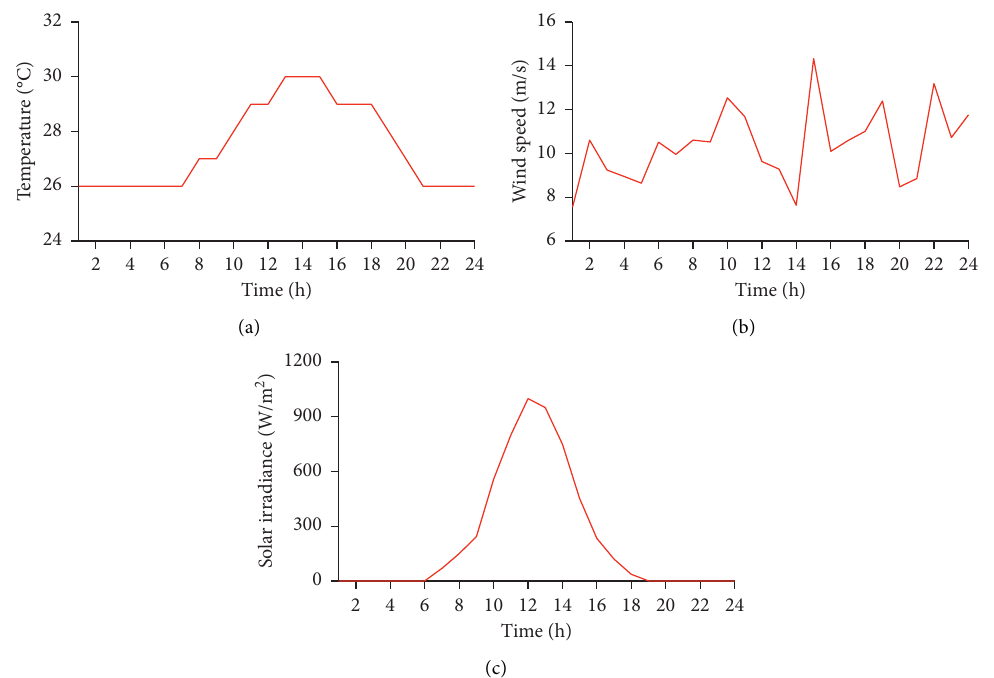
Figure 5: The hourly forecast temperature and renewable resources. (a) The temperature profile; (b) the solar irradiance profile; (c) the wind speed profile.